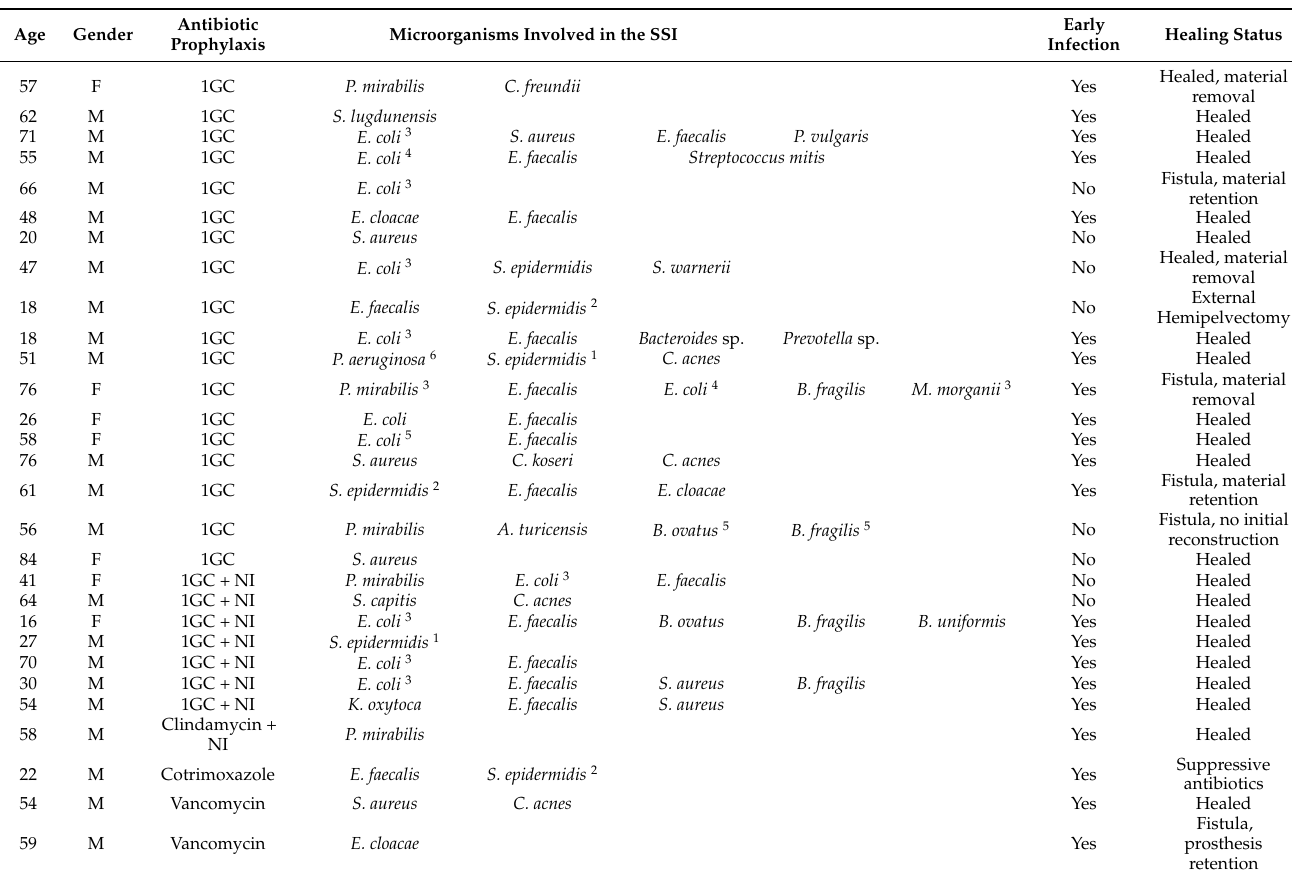
Table 4. Antibiotic prophylaxis, microorganism ecology, resistance, and healing